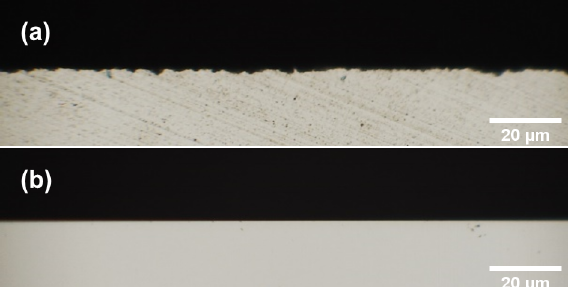
Figure 6. Optical images of the cutting edges for the roughness evaluation. The images are taken from the direction of the rake face. View field for all images is 160µm. ( a )SC-tool. ( b )